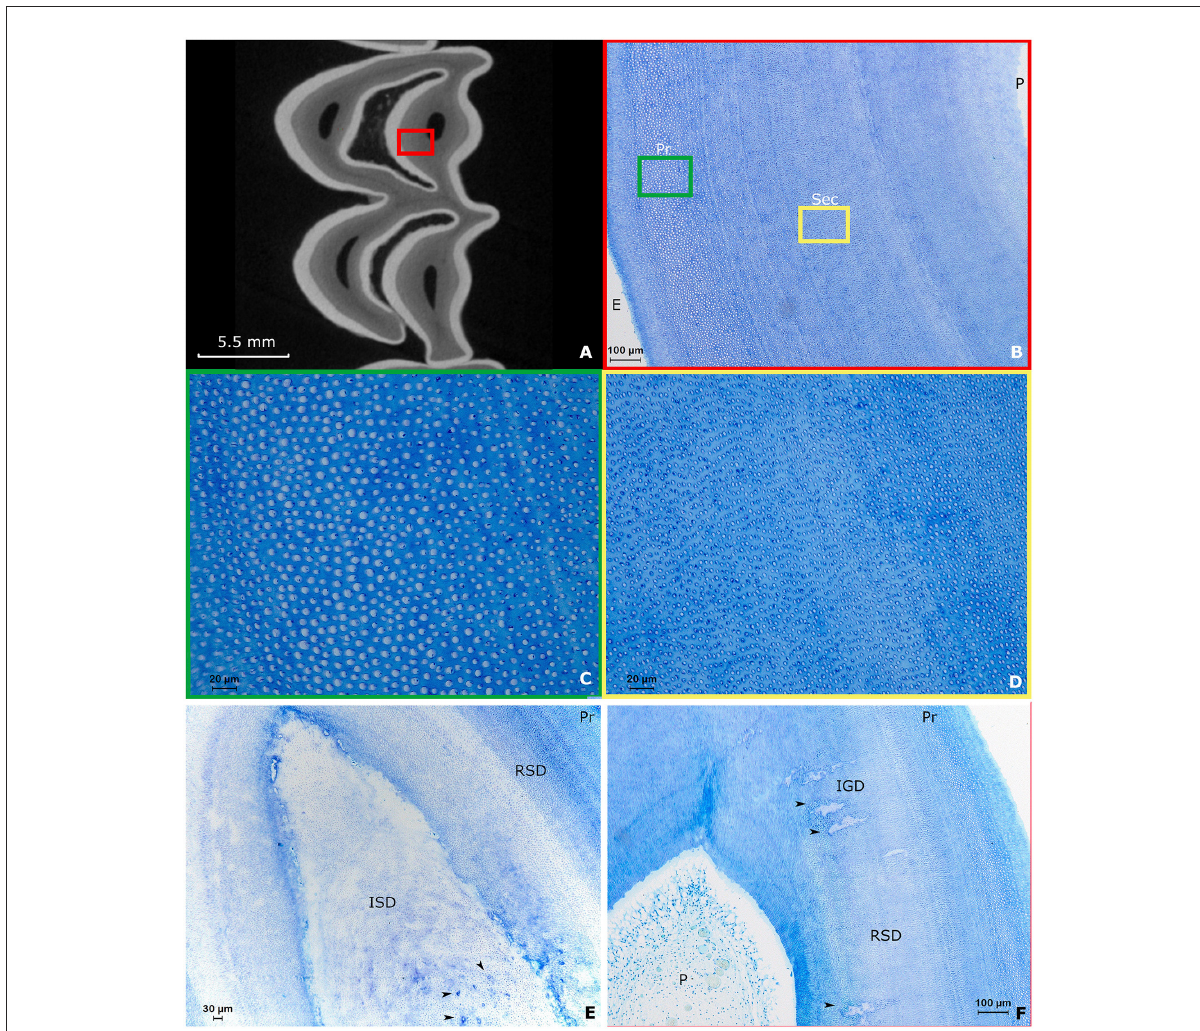
FIGURE3 Typical arrangement of dentin in alpaca cheek teeth. Images (A–D) : Second molar in the right upper jaw of a 4 years and 3 months old alpaca (Dental age of 2 years and 6 months). (A) Transverse subocclusal 2D-image acquired using µ -CT. The mesial column of the tooth is placed up. Note the tooth is not yet fully developed, indicated by the ‘open infundibulum’ at the level of the distal column. The enamel is displayed in white, the dentin in gray and the pulp horns are visible as black spots surrounded by dentin. A red square indicates the region studied using decalcified histology. (B) Overview of the normal histological arrangement of dentin in the alpaca. Close to the enamelodentinal junction, connecting dentin and enamel (E), primary dentin (Pr) can be found. When progressing toward the pulp (P), a transition occurs to secondary dentin (Sec). Note the multiple incremental lines present in the secondary dentin (Toluidin, 10x magnification). A green and yellow square indicate the enlarged region in (C , D) , respectively. (C) Detail of the primary dentin characterized by dentinal tubules surrounded by large amounts of peritubular dentin, whereby relatively small amounts of intertubular dentin are present (Toluidin, 40x magnification). (D) The secondary dentin is characterized by the absence of peritubular dentin. High amounts of intertubular dentin can be found in the secondary dentin. Remnants